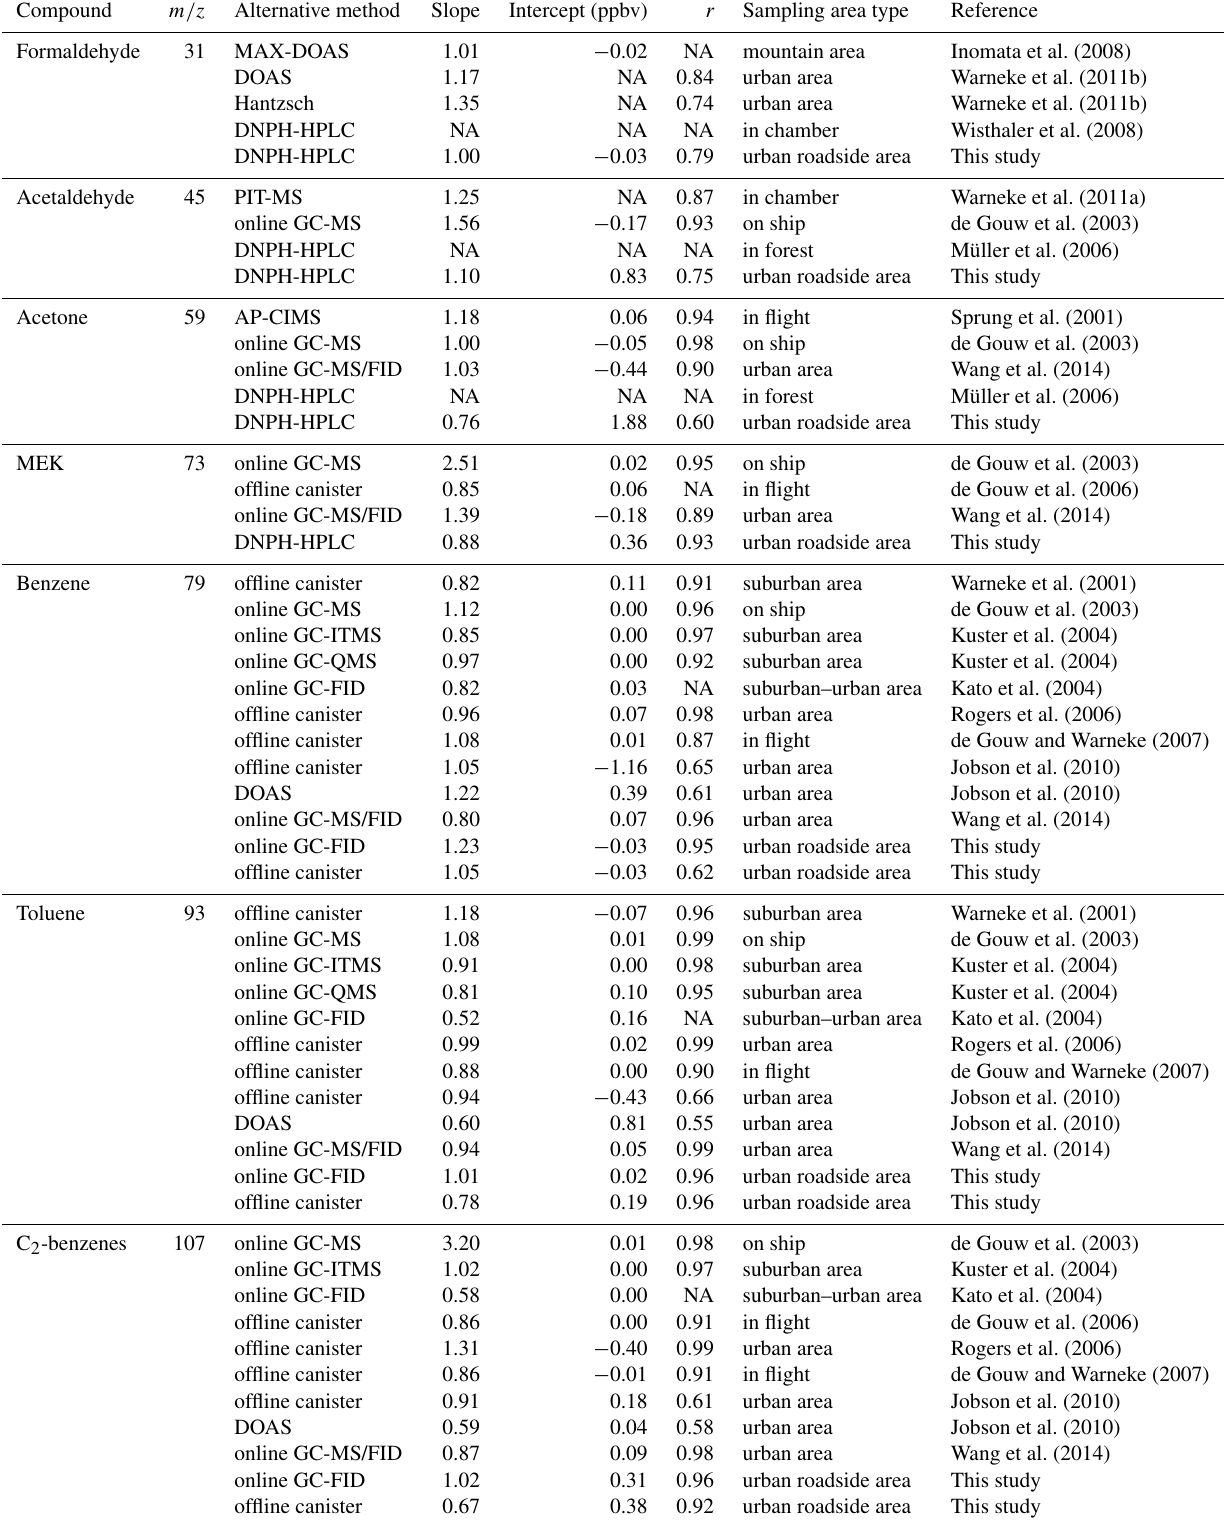
Table 4. Intercomparisons between PTR-MS and alternative methods in this study and the comparison with previous other studies.